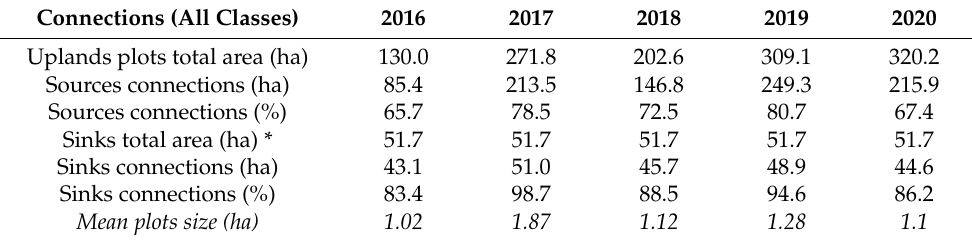
Table 6. Area by structural connectivity growth type since